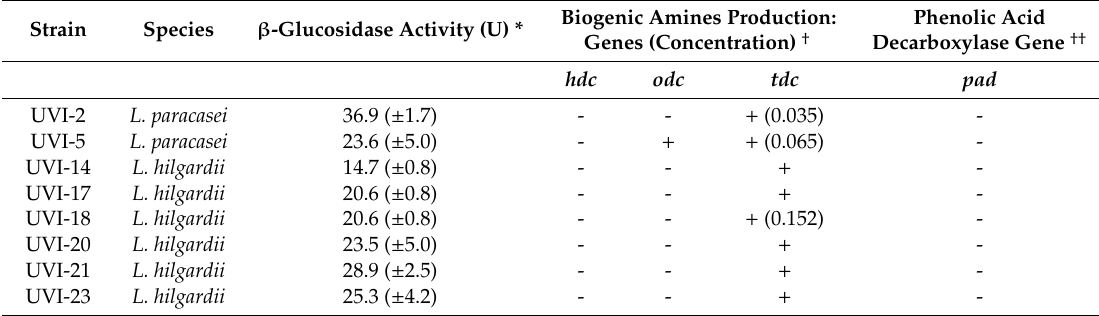
Table 3. Characterization of selected malolactic strains: β -glucosidase activity, biogenic amine formation capacity, and phenolic acid decarboxylase